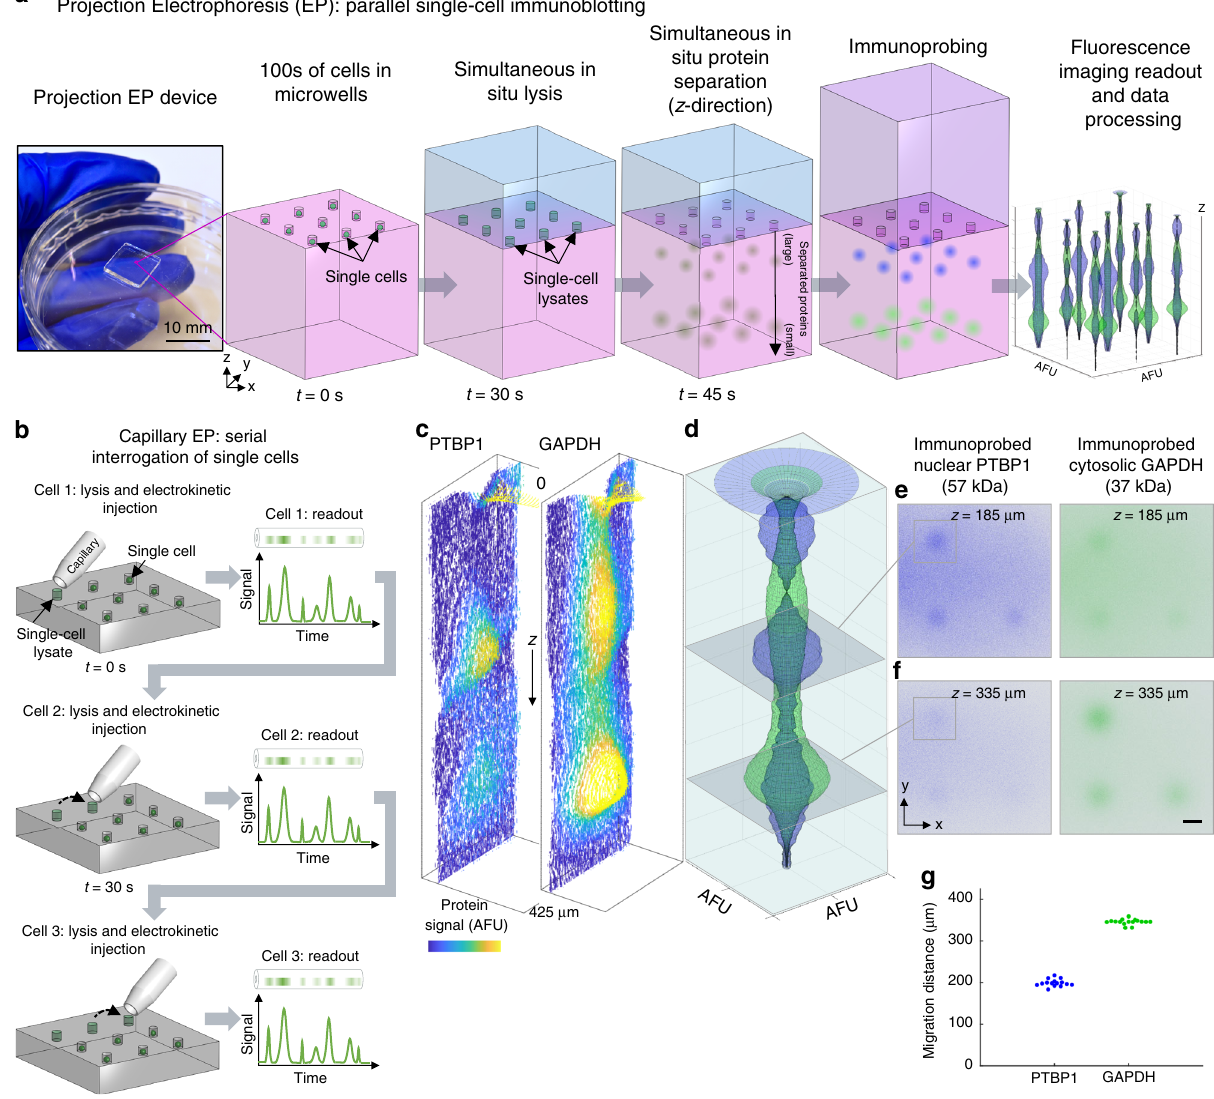
Fig. 1 Projection electrophoresis simultaneously lyses and separates both nuclear and cytosolic proteins from hundreds of single cells. ( a ) Projection electrophoresis device photograph and work fl ow schematic. A 9 × 9 mm projection electrophoresis PAG contains > 1000 microwells that each serves as a separation lane. Cells in PAG microwells are lysed in situ using a lysis buffer-soaked hydrogel delivery matrix, and the lysate is then electrophoretically injected into the polyacrylamide and proteins are separated by size through the depth of the gel. After separation, proteins are covalently linked to the gel matrix using a UV-initiated capture. All cells are lysed and analyzed simultaneously, the active assay time (from cell lysis to photocapture) is less than 90 s, and in situ analysis reduces potential losses from transfer steps. ( b ) In contrast, capillary electrophoresis analyzes cells in series, with each cell lysed and proteins separated at a different time. ( c – f ) Different visualizations of z -directional protein separation in a single separation lane. ( c ) xz ( y -summed) contour plots of background-subtracted protein signal within the separation lane for nuclear and cytosolic example proteins. Protein signal is visualized as peak height and false-colored. ( d ) z -directional intensity pro fi les (summed fl uorescence intensity in arbitrary fl uorescence units, AFU, vs. z ) for PTBP1 (nuclear, blue) and GAPDH (cytosolic, green) in the same lane, revolved around the z -axis to generate a 3D rendering of fl uorescence distribution. ( e , f ) Representative confocal xy slice images (representative of 9 confocal stacks acquired of different regions of 2 independent separation gels) for separated PTBP1 (blue) and GAPDH (green) at two z -depths into the gel (( e ) at the 185 µ m depth of the PTBP1 band; ( f ) at the 335 µ m depth of the GAPDH band). Each slice image shows 4 separation lanes, 3 of which appear to have been occupied by BT474 cells prior to analysis. Overlaid squares depict xy regions of interest for the lane plotted in ( c ) and ( d ), over which fl uorescence intensities were summed to yield z -directional intensity pro fi les. Scale bar represents 50 μ m. ( g ) Quanti fi ed z -migration distances for PTBP1 (57 kDa) and GAPDH (37 kDa) from n = 15 (PTBP1) and n = 17 (GAPDH) separation lanes. Source data are provided as a Source Data fi